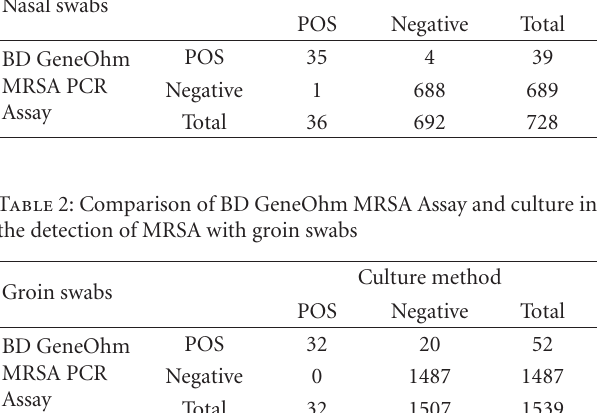
Table 3: Sensitivity, specificity, positive predictive value (PPV), and negative predictive value (NPV) of the BD GeneOhm Assay MRSA real-time PCR using nasal and groin swabs.